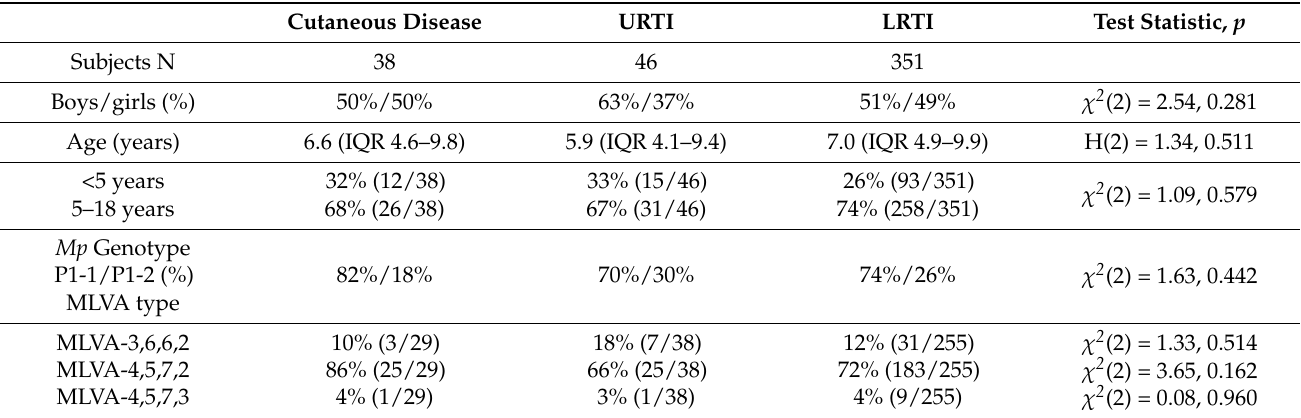
Table 1. Epidemiologic characteristics and Mycoplasma pneumoniae genotype distribution in patients with cutaneous disease, upper and lower respiratory tract infection. Data are presented as median (IQR) or as percentage (proportion of subjects).